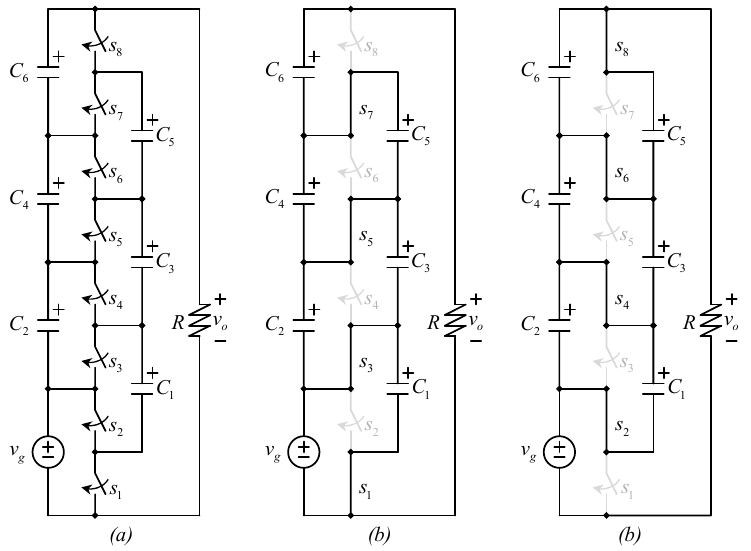
Figure 12. The Ladder Converter is another possible extension to the circuit in Figure 9. ( a ) Converter topology, ( b ) equivalent circuit when the firing signal is high, and ( c ) equivalent circuit when the firing signal is low.